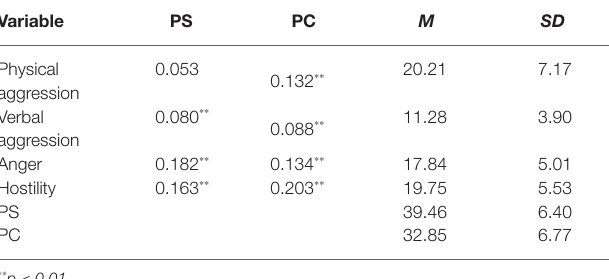
TABLE 1 | Pearson correlation between the variables of study and the descriptive statistics. Variable